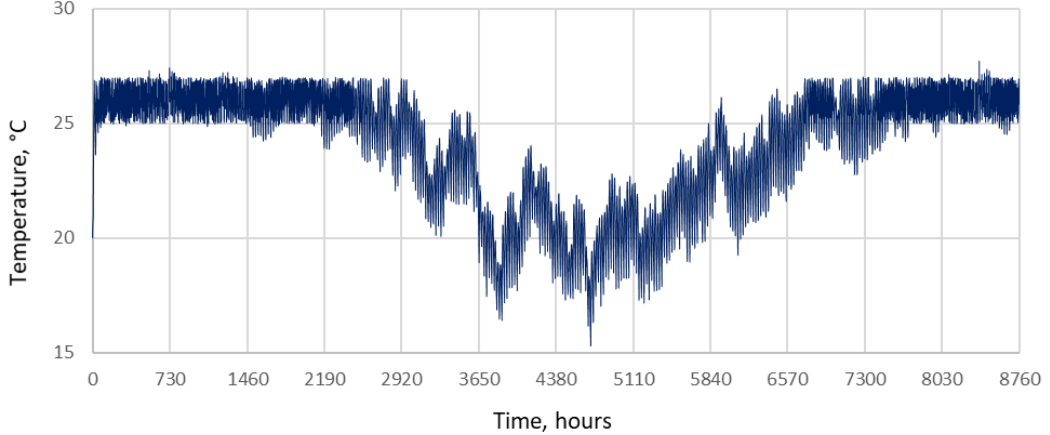
Figure 7. Living room temperature profile.